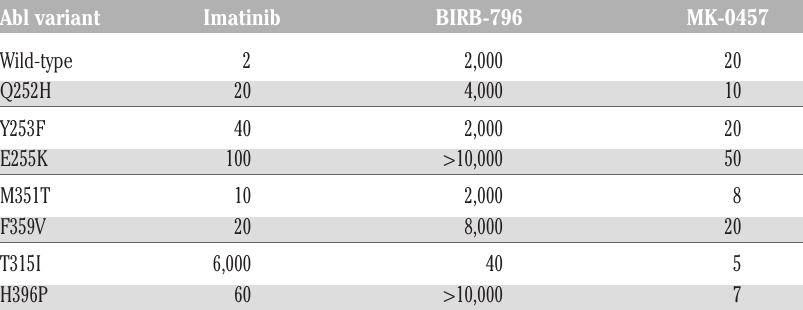
Table 3. Comparison between the binding affinity of imatinib and of the aurora kinase inhibitors BIRB-796 and MK-0457 for wild-type and drug-resistant Abl variants. Adapted from [21].